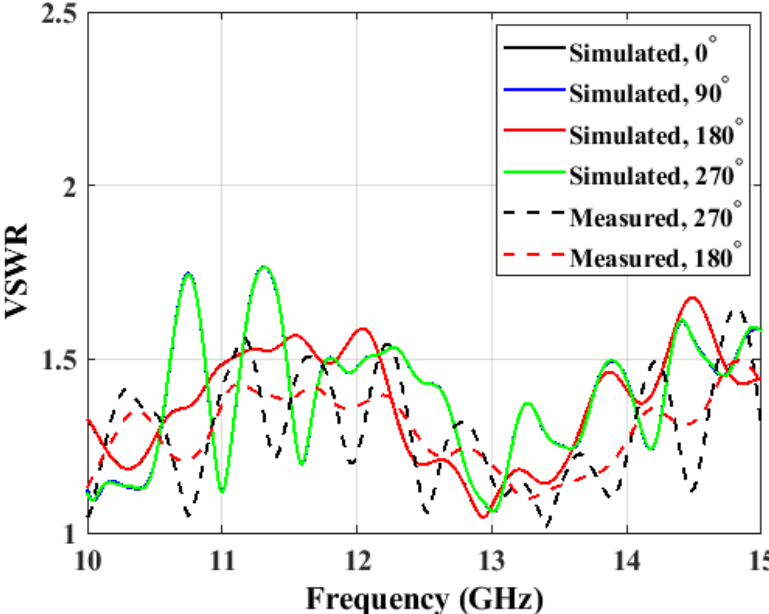
Figure 16. Simulated and measured VSWR of proposed BDS